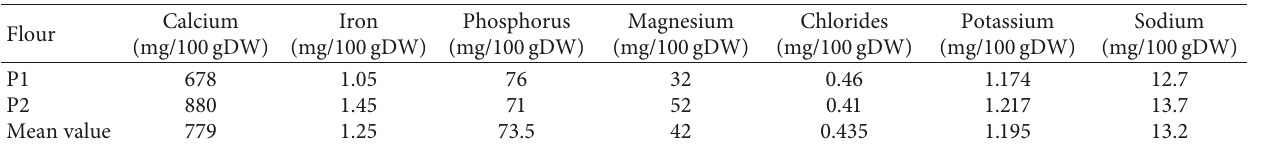
Table 8: Mineral content in dried flour of